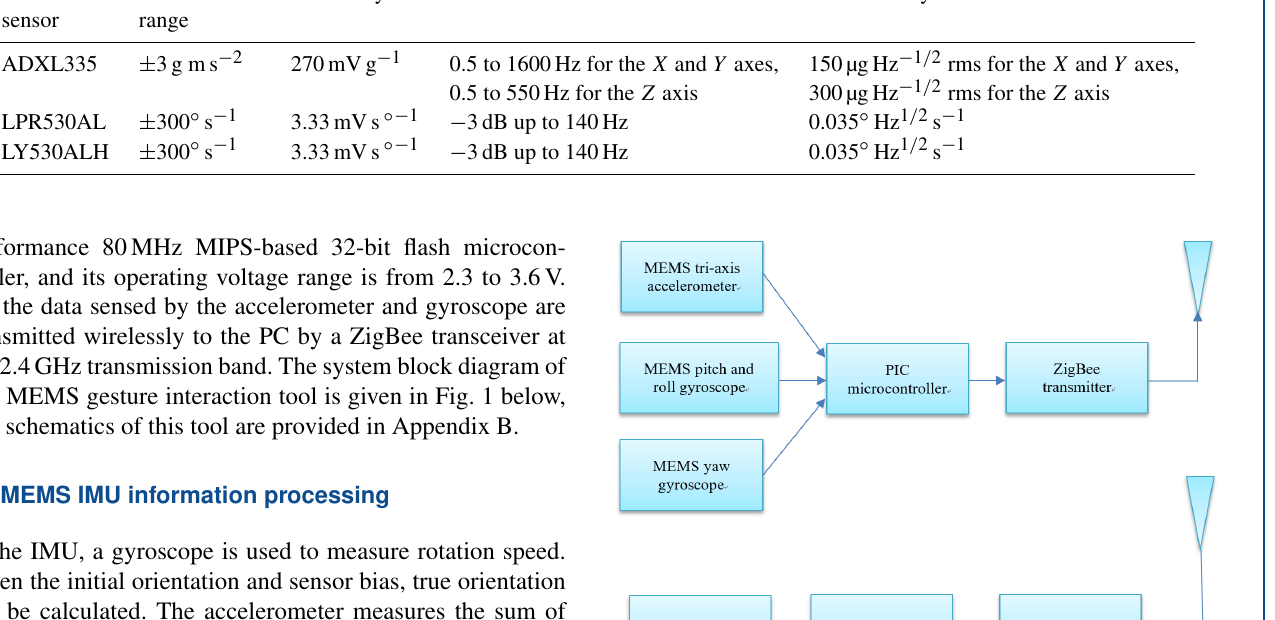
Table 1. Specifications and characteristics of MEMS sensors in the system. MEMS